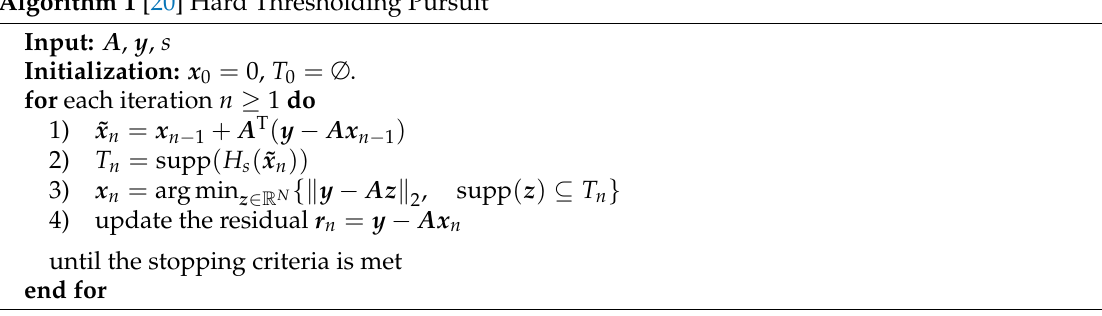
Figure 3. Block diagram of CGHTP algorithm. T n is the support set of x in the n th iteration, “LSM” denotes least square method. Algorithm 1 [20] Hard Thresholding Pursuit